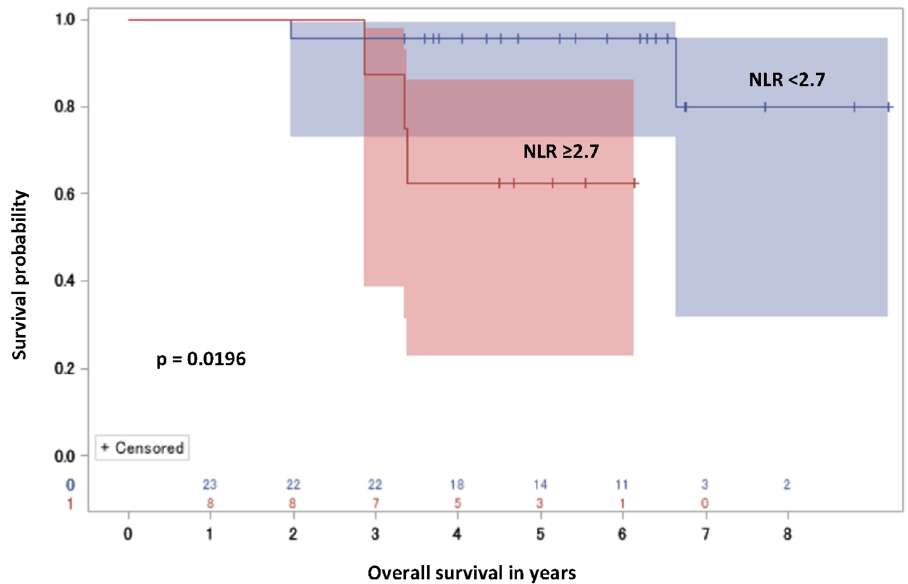
Figure 2. Overall survival for pN1 patients stratified with NLR (≥ 2.7 vs < 2.7). Graphics were printed using SAS